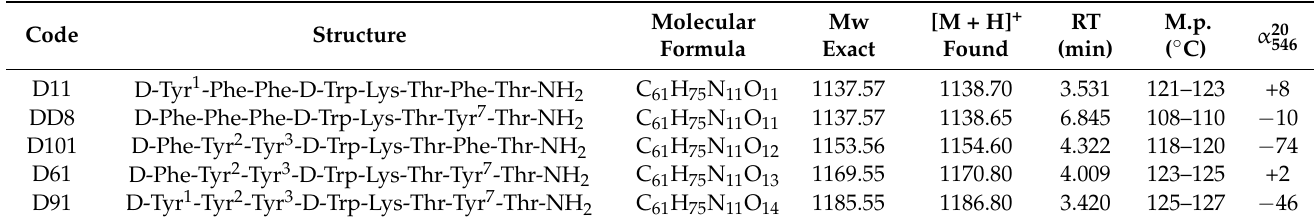
Table 1. Structures, data and constants of newly synthesized analogs of BIM-23052.